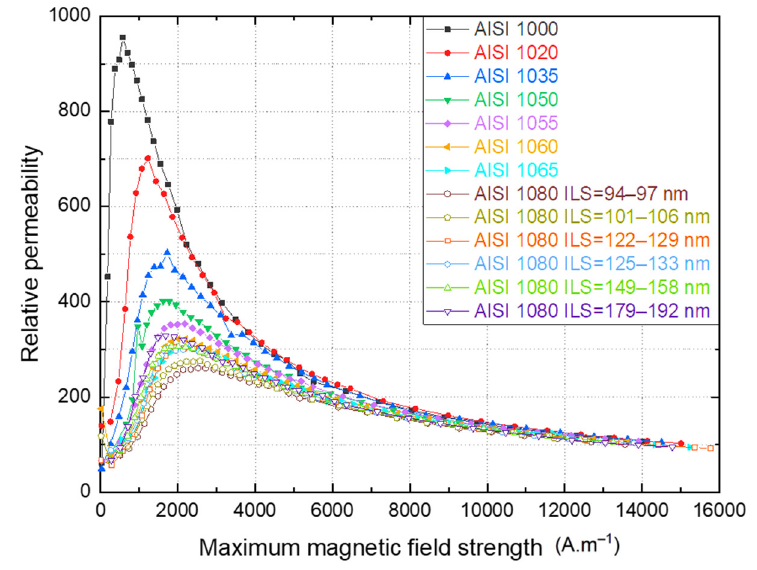
Figure 7. Variation of the relative permeability as a function of the maximum magnetic field strength of carbon steels of groups A and B.